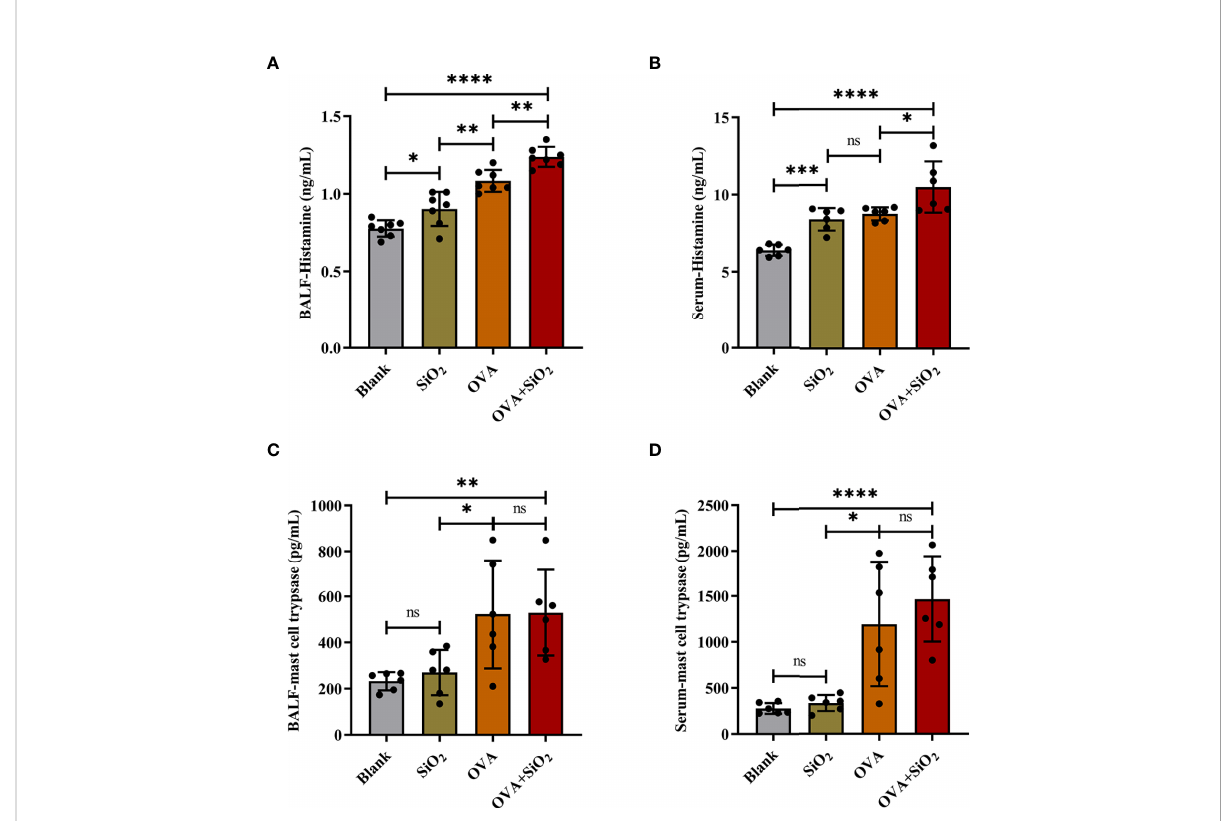
FIGURE 4 The levels of histamine and mast cell tryptase in BALF and serum of the OVA-induced asthma model. Data are presented as the mean ± SD. The unpaired t test or ordinary one-way ANOVA was used to compare different groups. * P < 0.05, ** P < 0.01, *** P < 0.001, **** P < 0.0001. ns, no signi fi